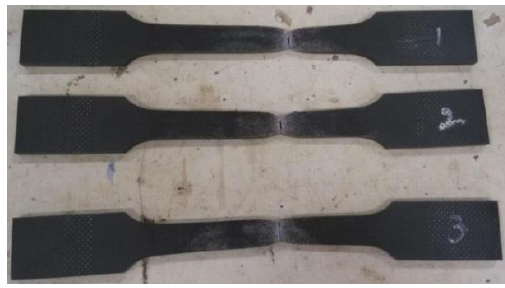
Figure 6. Material tensile test. ( a ) Installation; ( b ) fracture.